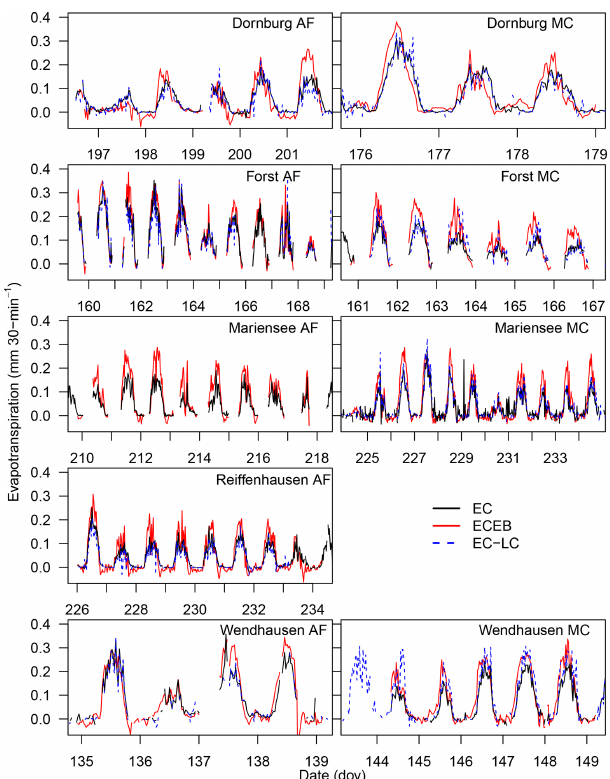
Figure 4. Time series of half-hourly evapotranspiration rates of an exemplary time period for ECEB, EC-LC, and EC as a reference for all sites. Time series of half-hourly ET rates for Reiffenhausen MC are missing due to the unavailability of a campaign, and ET EC-LC at Mariensee AF are missing due to technical problems with the sensor during the campaign. The presented time series were not corrected for the energy balance non-closure. Gaps in nocturnal data are due to the limited power availability from the solar power supply.